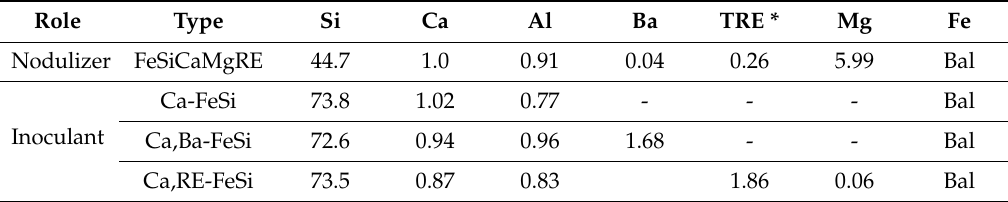
Table 1. Treatment Alloys (wt.%).